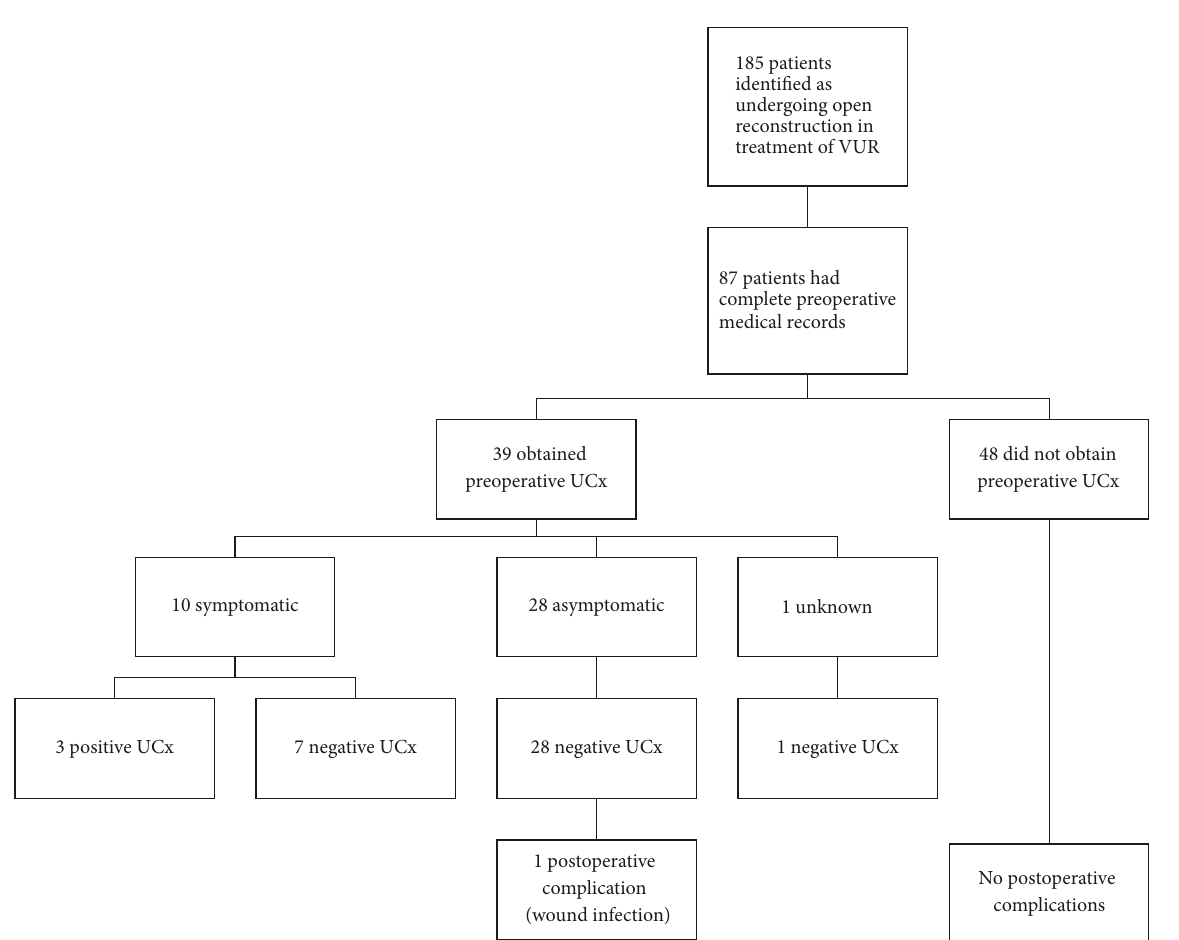
Figure 1: Preoperative urine culture results and postoperative